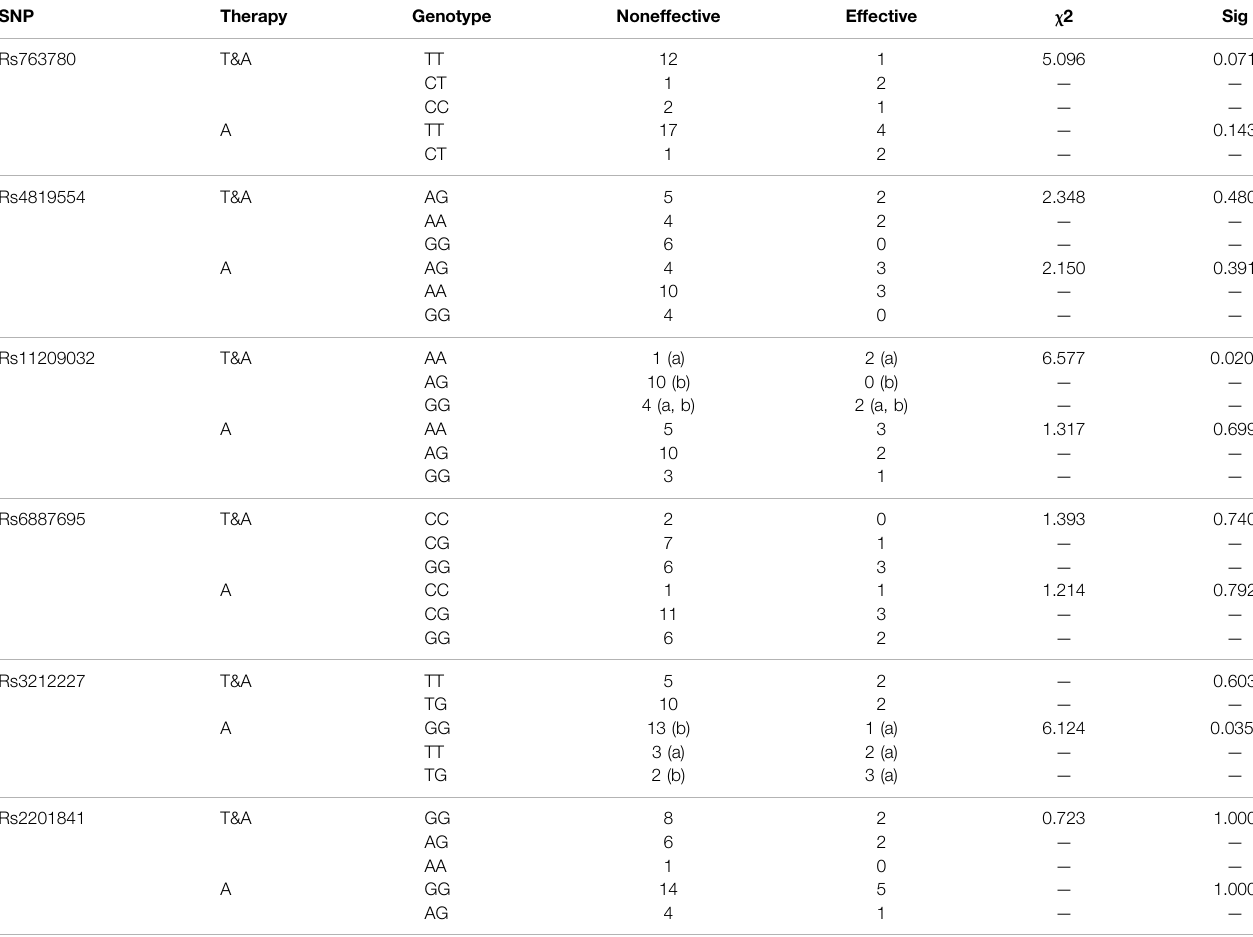
TABLE 4 | Comparison of the relationship between each SNP and the ef fi cacy of acitretin alone or the ef fi cacy of acitretin treating secondary non-response to TNF-a biological agents. SNP